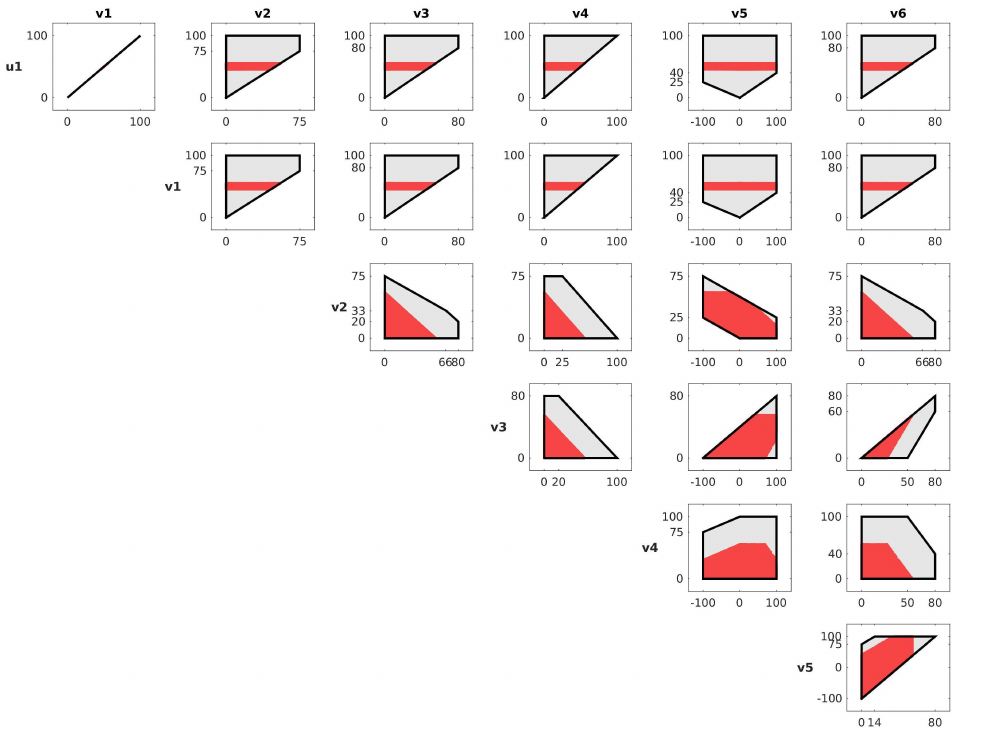
Figure 5. Effects of parameter Km u 1 on C . Pairwise projection of ν ( x ∗ ) on the solution space C when Km u 1 varies between 4 and 6 and when the other parameters vary between 10 − 5 and 10 5 time their default value. Only the 6 first reactions are presented. The full picture is in Supplement Figure